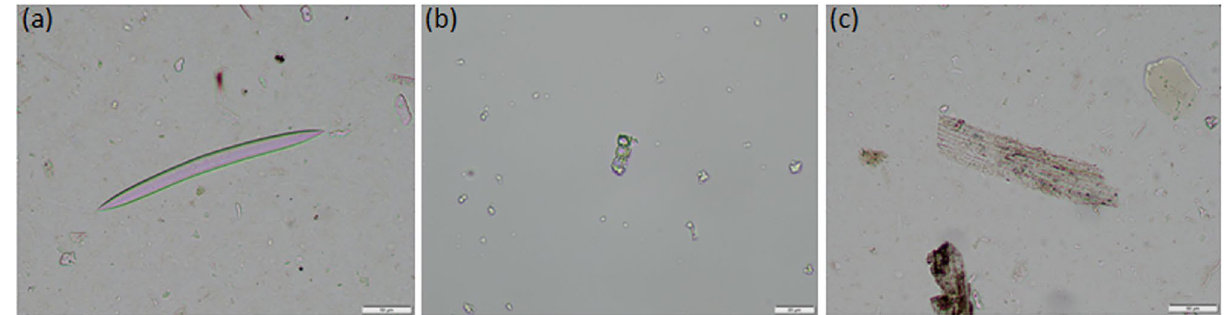
Figure 7. Photomicrographs of phytoliths and other siliceous microfossils identified in the samples (200 × or 400 ×). ( a ) Sponge spicule; ( b ) articulated spheroid phytoliths from dicotyledonous plants; (c) multicelled elongate phytoliths from